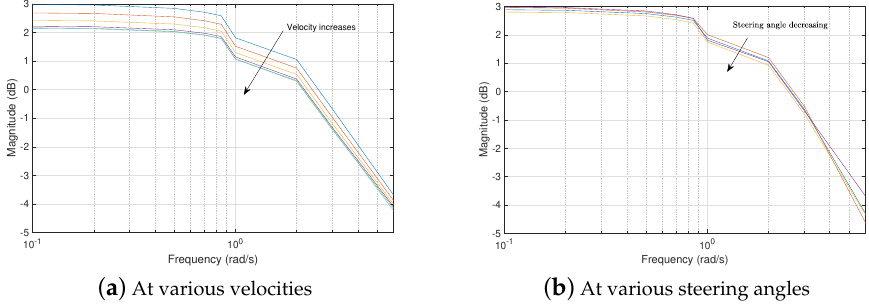
Figure 8. Transfer functions of the error of the neural